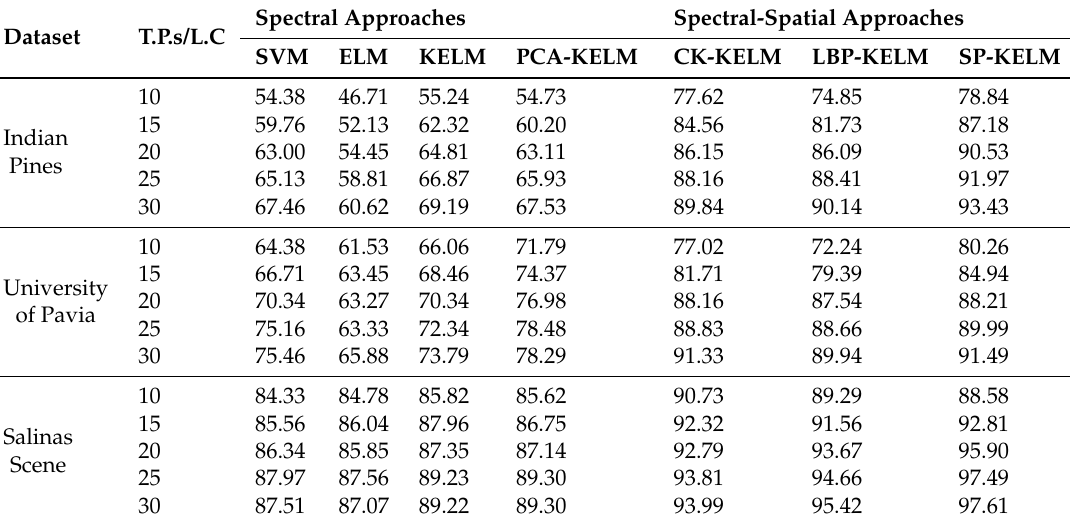
Table 5. Overall accuracies of all baselines with different numbers of training pixels.